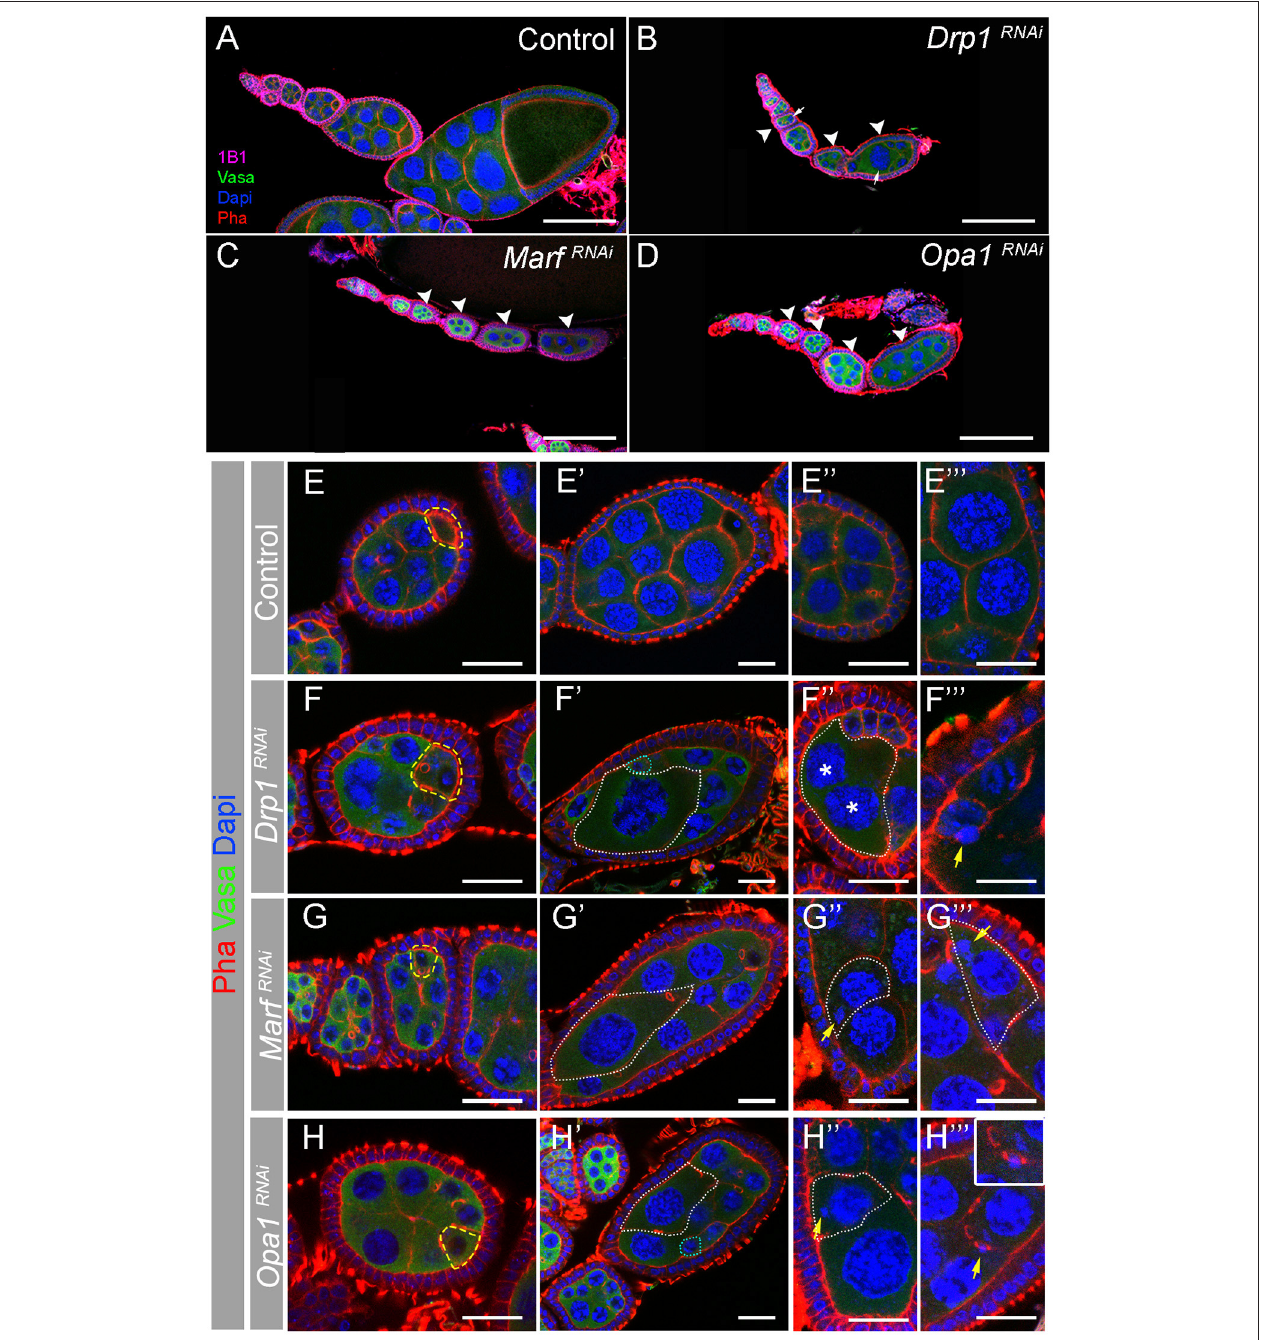
FIGURE 4 | Depletion of Drp1 , Marf , or Opa1 induces multiple egg chamber defects. (A–D) Representative images of ovarioles from indicated RNAi driven by nos Gal4. Germ cells are marked with Vasa antibody (green). Fusomes are labeled with Hts (1B1, pink). Nuclei and F-actin are labeled by DAPI (blue) and Phalloidin (Pha, red), respectively. Scale bars represent 100 µ m. Control ( mCherry RNAi ) ovariole (A) with a germarium in its anterior tip and a series of egg chambers progressively older. Drp1 RNAi (B) , Marf RNAi (C) , or Opa1 RNAi (D) egg chambers degenerate before entering vitellogenic stages 8 and 9. When disrupting mitochondrial dynamics, egg chambers lose their normal structural organization presenting multiple defects in nurse cells morphology (arrowheads). (E–H) Several egg chamber defects are observed when mitochondrial dynamics regulators are knocked down. Abnormal egg chambers (F–H) are typically detected from egg chamber stage 3 or 4. Oocytes seem to be correctly specified based on the accumulation of F-actin in the posterior tip of egg chambers (outlined by dashed yellow line). (E ′ -H ′ ) Egg chambers are severely disorganized in Drp1 RNAi , Marf RNAi , and Opa1 RNAi . Nurse cells show uneven cytoplasmic and nuclear size (white dashed lines). (E ′′ –H ′′ , E ′′′ –H ′′′ ) Magnified areas show the variety of defects observed in abnormal egg chambers: multinucleated cells ( F ′′ , cell membrane is outlined by white line, and nuclei are labeled by asterisks) and DNA mislocalized in the cytoplasm (G ′′ ,G ′′′ ,H ′′ ) , in contact with cell membranes (F ′′′ ) or with ring canals ( H ′′′ , see magnified area). Scale bars represent 20 µ